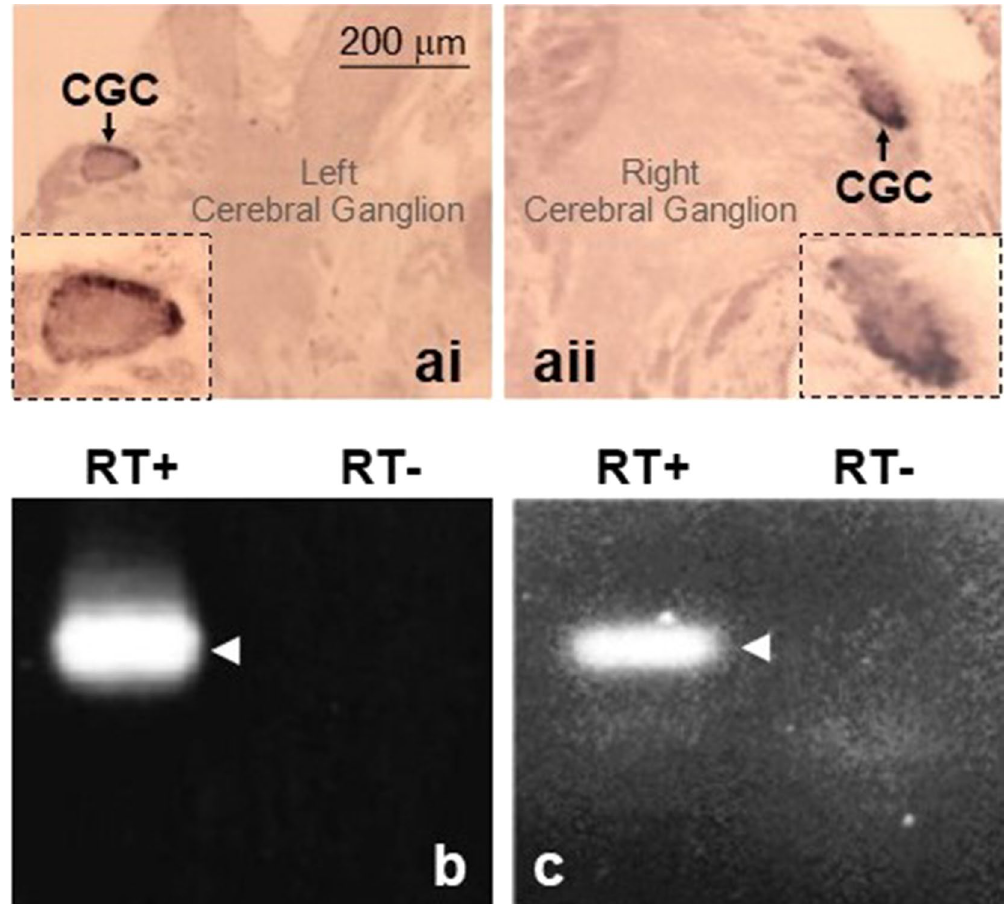
Figure 3. Lym-NOS1 mRNA and Lym-NOS1AS NAT are expressed in the CGC. ( a ) In situ hybridization shows a bilaterally symmetrical pair of large neuronal cell bodies in the left (ai) and right (aii) cerebral ganglia (see Fig. 2a for location of the cerebral ganglia in the brain) stained with the Lym-NOS1 mRNA specific probe. The cell bodies correspond in size and position to the identified CGCs (arrowed). Of note, there are several thousands of other types of neurons in the cerebral ganglia, but they are poorly stained, indicative of a very low level of the Lym-NOS1 mRNA. The dotted line boxes show the stained CGCs at a higher magnification. It is worth mentioning that the CGC has a very large nucleus that fills a significant part of the cell but only the cytoplasm shows significant hybridization, as expected. ( b , c ) The results of conventional RT-PCR experiments conducted on RNA extracted from isolated CGCs to detect Lym-NOS1 ( b ) and Lym-NOS1AS ( c ). The ‘RT+’ lanes show that the PCR products (arrowed) of the expected sizes (101 bp in case of Lym-NOS1 and 108 bp in case of Lym-NOS1AS ) are detected indicating that the CGCs express both Lym-NOS1 and Lym-NOS1AS . The ‘RT−’ lanes represent the outcome of the control experiments in which reverse transcriptase was omitted. The absence of the amplification products in these lanes is indicative that the RNA preparation was free of DNA